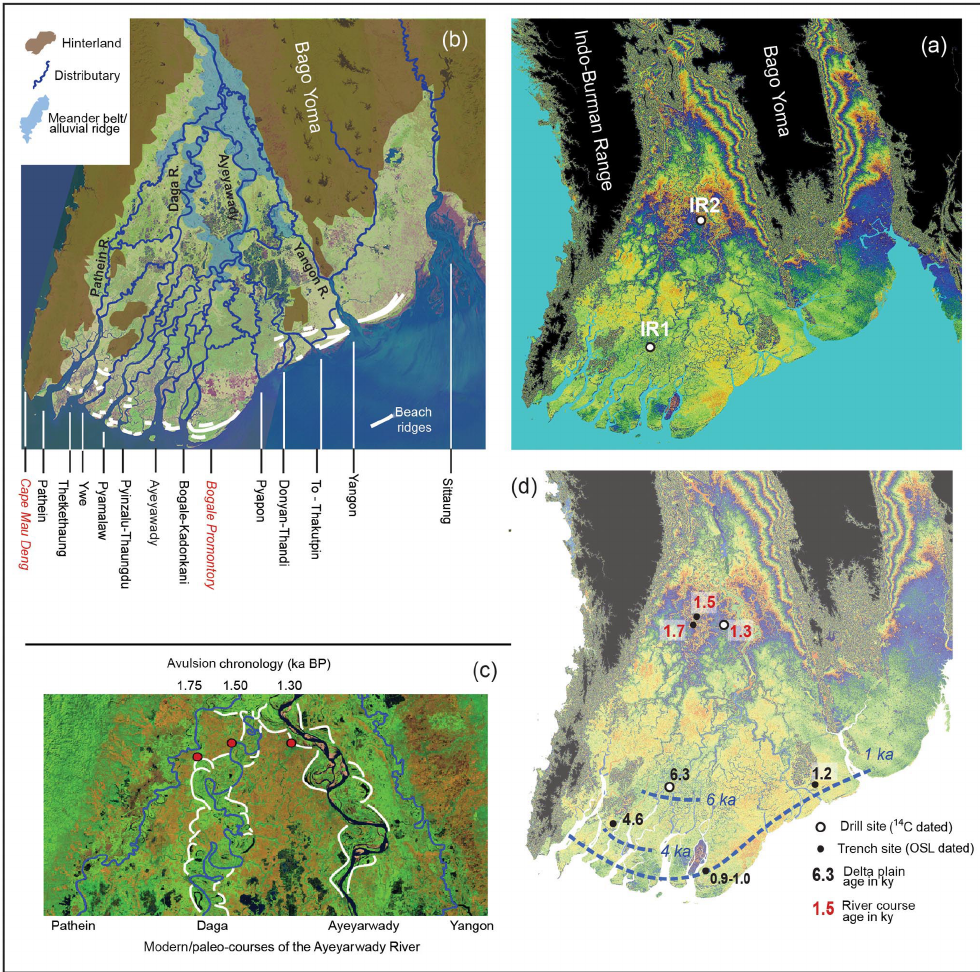
Figure 2. (a) SRTM-derived DEM for the Ayeyawady delta region (pattern of colors repeats every 10 to 300m in height; higher land in black); (b) large-scale features of the Ayeyawady delta region with identified river and distributary courses and mouths as well as beach ridges shown on an ASTER satellite photo; (c) sample locations and chronology on the meander belts documenting the avulsion near the delta apex (meander belts as white lines delimited from ASTER and Google Earth images); (d) preliminary model of the Ayeyawady delta evolution with sampling locations and types with chronological information on the youngest fluvial deposits and beach